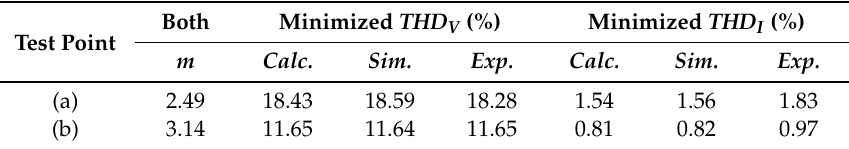
Table 3. Minimized voltage and current THD s—same switching angles.